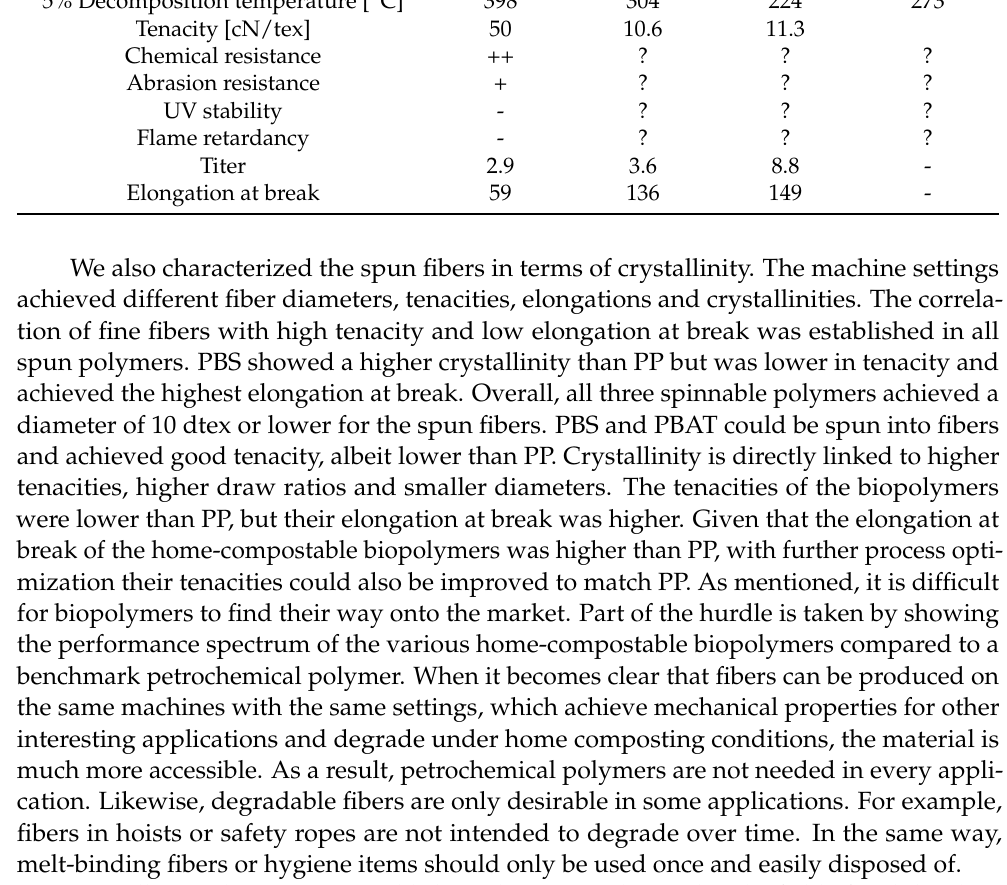
Table 7. Summary of the parameters determined in this study for four polymers. Parameter PP PBS PBAT TPS Density [g/cm 3 ] 0.91 1.26 1.25 >1 Glass transition temperature [ ◦ C] − 15 − 38 − 33 Melting temperature [ ◦ C] 170 113 125 Decomposition temperature [ ◦